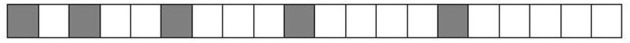
Pattern of the presentation of the US during the extinction phase for the gradual group. Each box symbolizes the presentation of a CS+, which was paired with an US at the colored boxes.